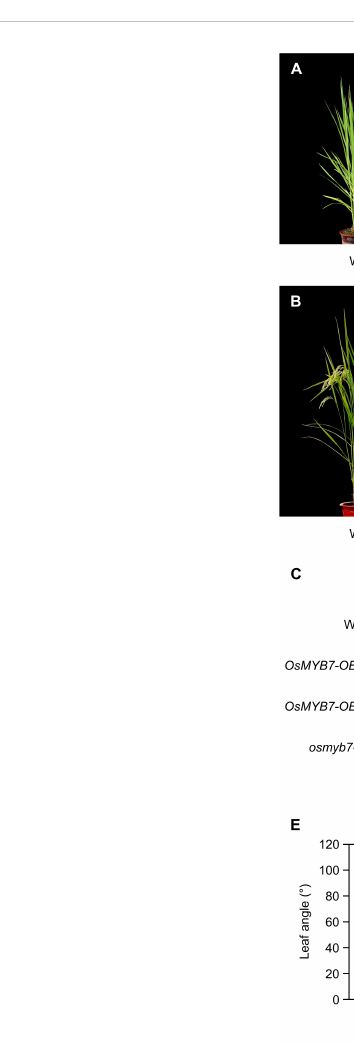
FIGURE 2 OsMYB7 determines leaf angle at the late stage of lamina joint development. (A, B) Phenotypes of WT, OsMYB7-OE1 , OsMYB7-OE2 , osmyb7-1 , and osbhlh079-D plants at the booting stage (105 DAS) (A) and at the ripening stage (30 DAH) (B) grown under natural long day conditions in a paddy fi eld. The osbhlh079-D plant represents a typical mutant with increased leaf angles due to enhanced BR signaling. Scale: 10 cm. (C, D) Lamina joints of WT, OsMYB7-OE1 , OsMYB7-OE2 , and osmyb7-1 plants. Samples in (C, D) were obtained from the plants shown in (A,B) , respectively. Scale: 1 cm. (E, F) Leaf angle in WT, OsMYB7-OE1 , OsMYB7-OE2 , and osmyb7-1 plants at the booting stage (105 DAS) (E) and at the ripening stage (30 DAH) (F) grown in a paddy fi eld. Data are presented as means ± SD from fi ve independent plants (5 leaf angles per plant). Asterisks indicate signi fi cant differences compared to WT as determined by two-tailed Student ’ s t -test (* P < 0.05, ** P < 0.01, and *** P < 0.001). DAH, days after heading; DAS, days after sowing; NS, not signi fi cant; n th LJ, lamina joint of n th